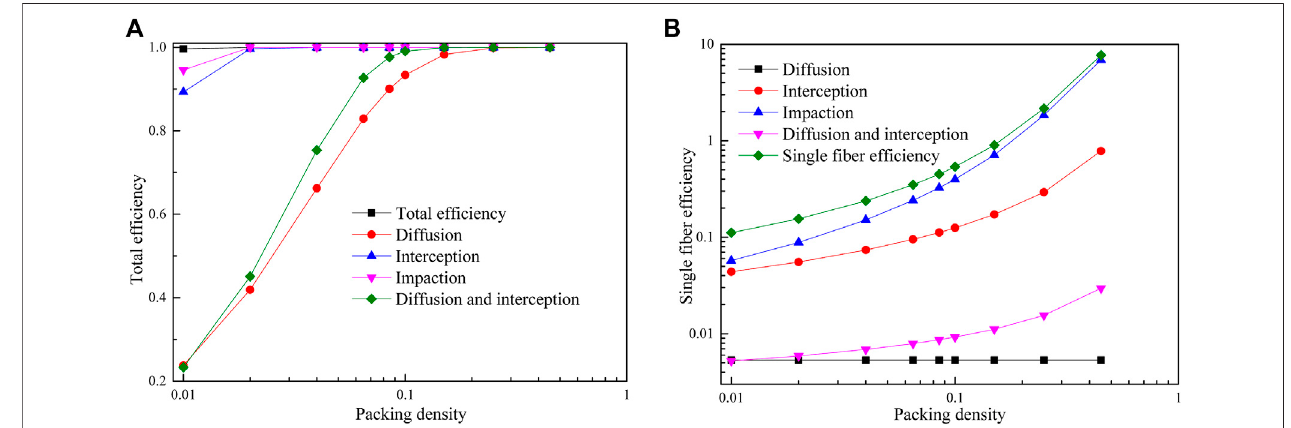
FIGURE 9 | Effect of packing density on fi ltration ef fi ciency: (A) Total fi lter ef fi ciency; (B) Single- fi ber ef fi ciency.